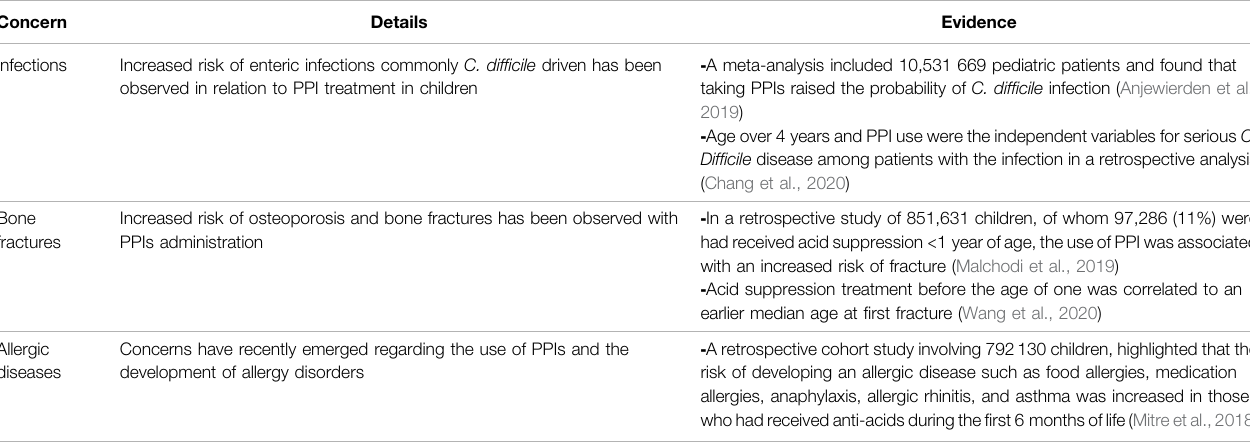
TABLE 3 | Some relevant studies on PPIs safety in